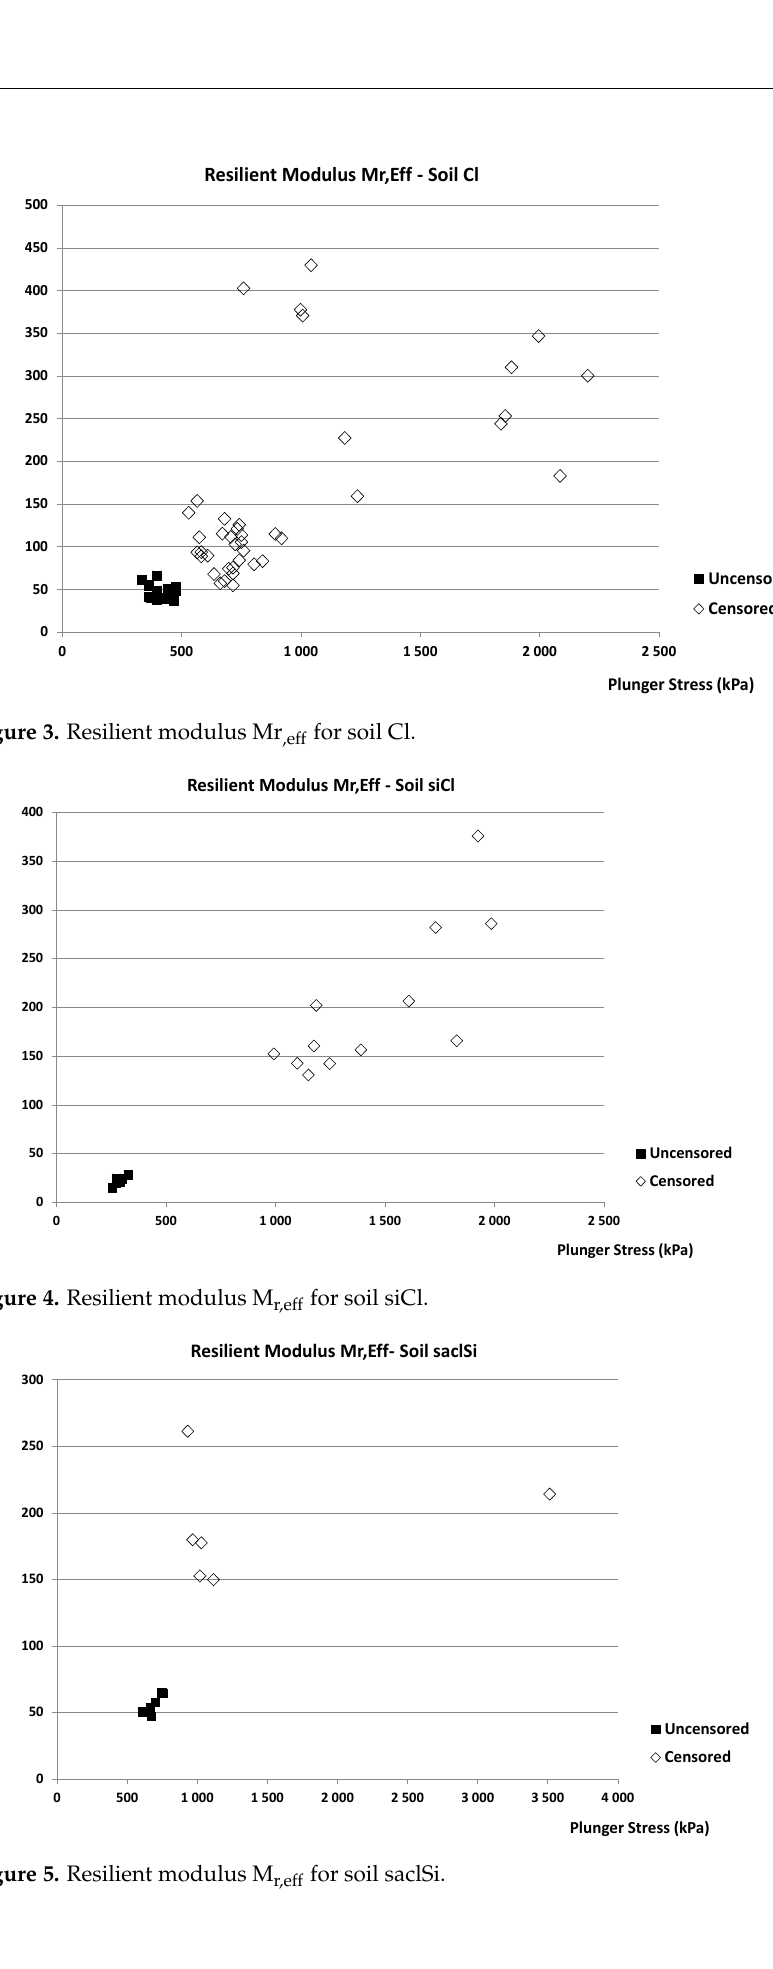
Figure 5. Resilient modulus M r,eff for soil saclSi. Soil csaCl The csaCl class contained in total 5 samples and 30 specimens. From these, six speci- mens were cycled at a mean stress of 579 kPa with a maximum limit of 630 kPa, which is